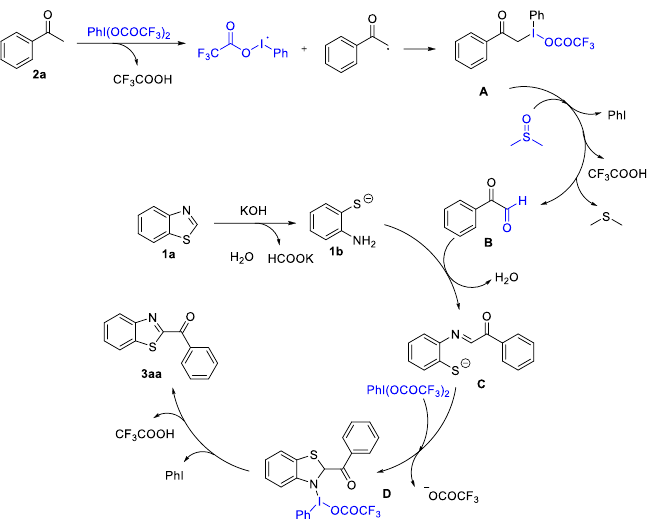
Figure 6. Plausible